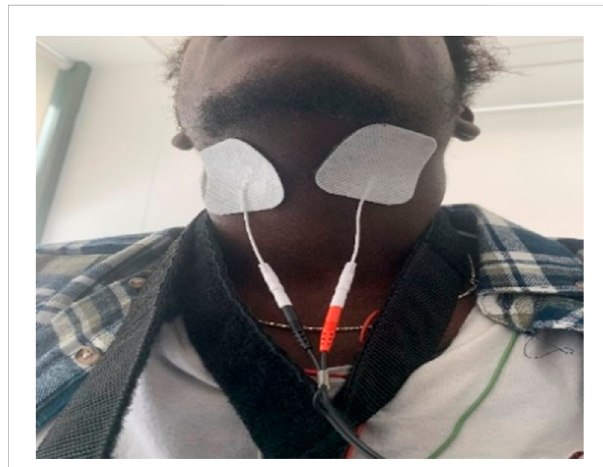
FIGURE 1 Placedinthesubmentalareamidwaybetweenangleofmandible and the chin as described previously (Steier et al.,